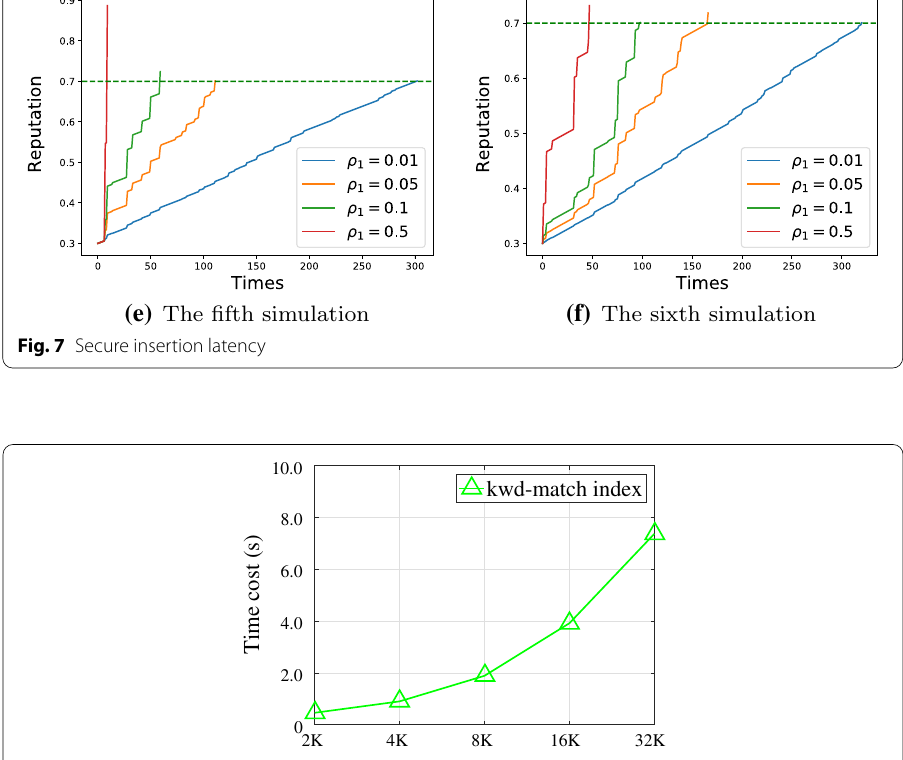
Fig. 8 Secure deletion